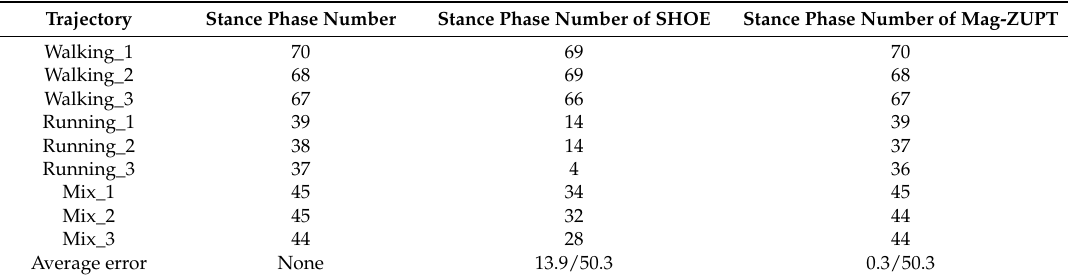
Table 4. Stance phase estimation accuracy of SHOE and mag-ZUPT.